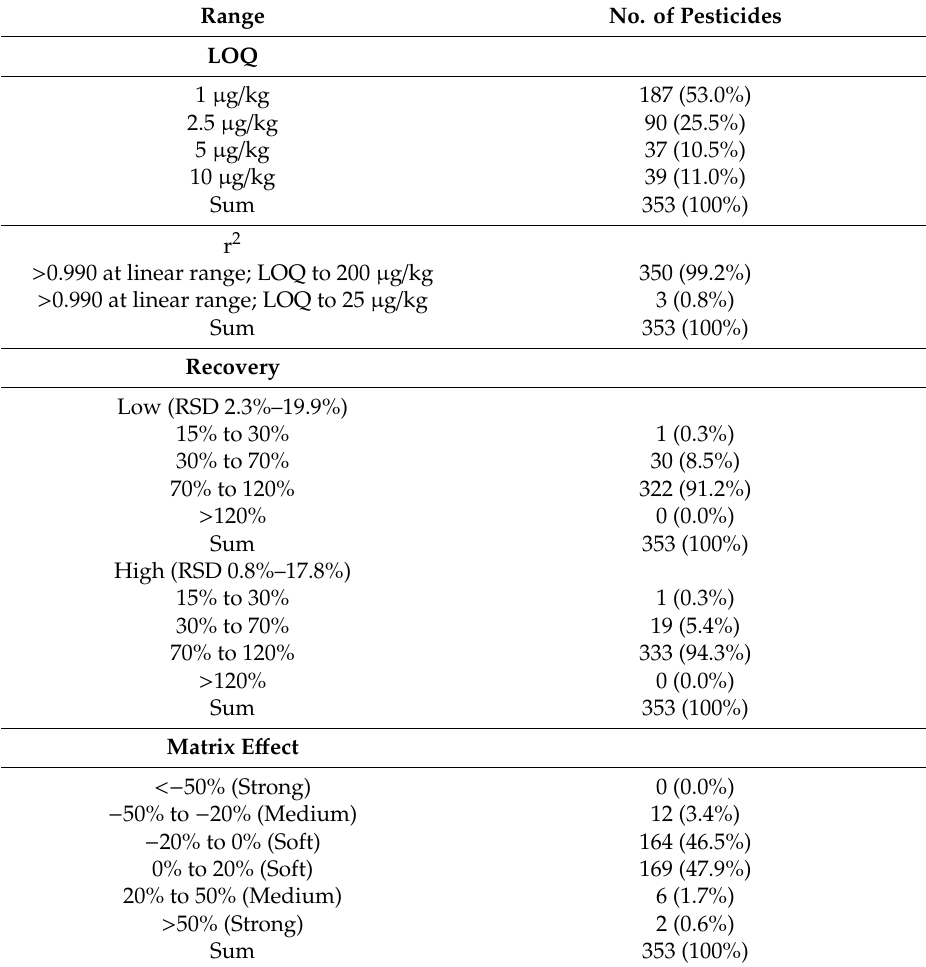
Table 4. Summary of method validation parameters; LOQ, linearity of calibration ( r 2 ), recovery, and matrix e ff ect for the 353 target